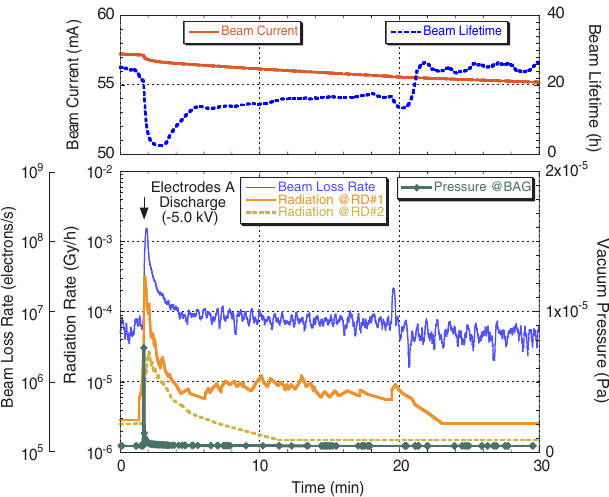
FIG. 6. (Color) Experimental data recorded when the beam life- time decreased because of electric discharge. The discharge was artificially induced by applying a DC HVof (cid:2) 5 : 0 kV at the time indicated by the arrow. Upper graph: beam current and beam lifetime; lower graph: beam loss rate, radiation intensity, and vacuum